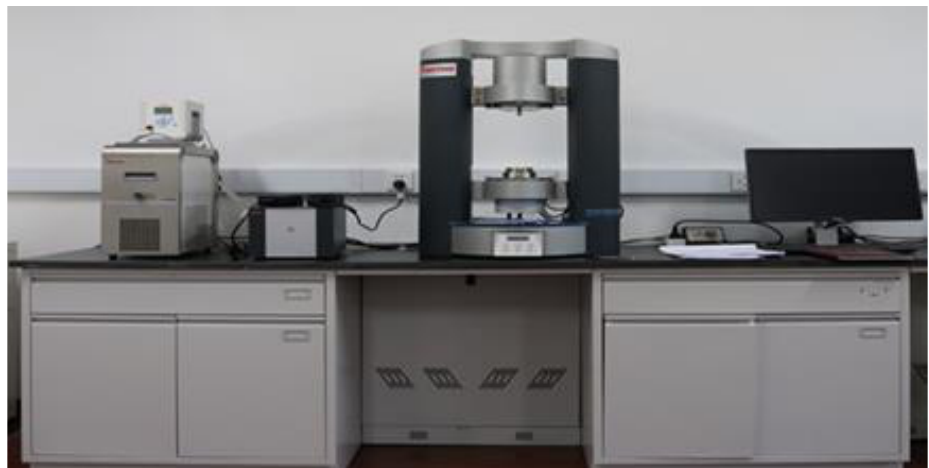
Figure 2. Haake Mars III rheometer.